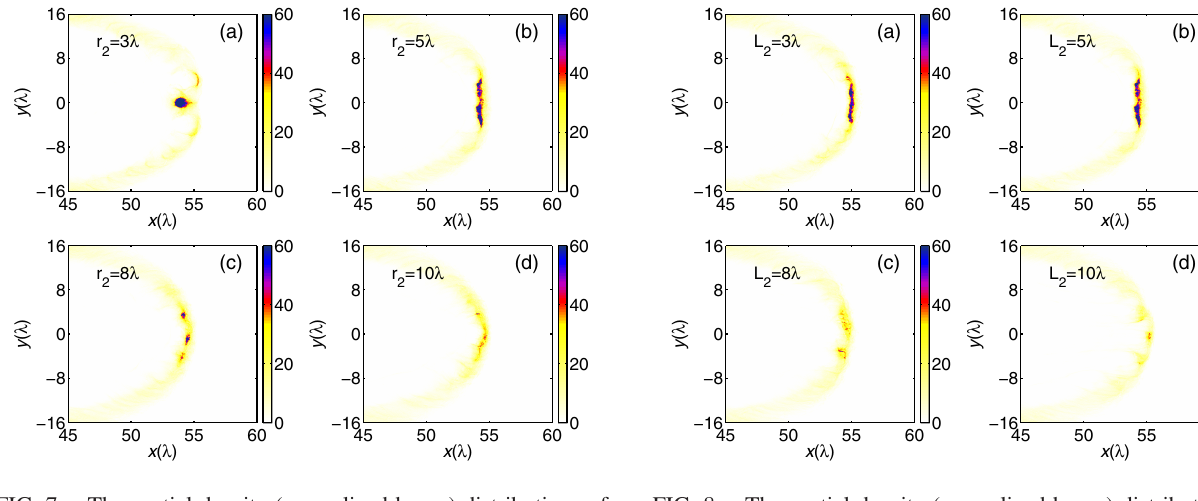
FIG. 7. The spatial density (normalized by n c ) distributions of the proton with different waist radiuses of the auxiliary laser. The waist radius r 2 ¼ 3 λ in (a), r 2 ¼ 5 λ in (b), r 2 ¼ 8 λ in (c), and r 10 λ in (d), respectively. These snapshots are corresponding 2 ¼ to the moment t ¼ 42 T L .